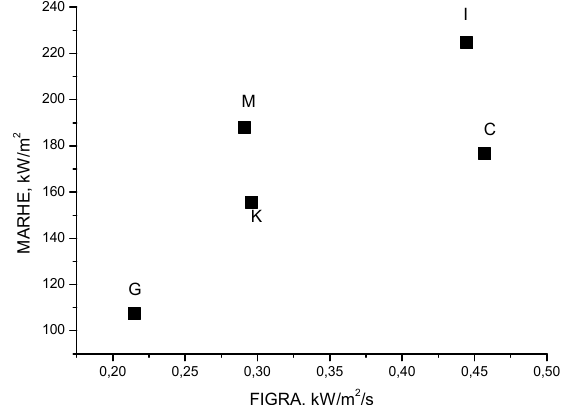
Figure 5. Correlation between MARHE and FIGRA parameters (average values) for respective samples of tropical woods: C—Cumaru, G—Garapa, I—Ipe, K—Kempas, M—Merbau.